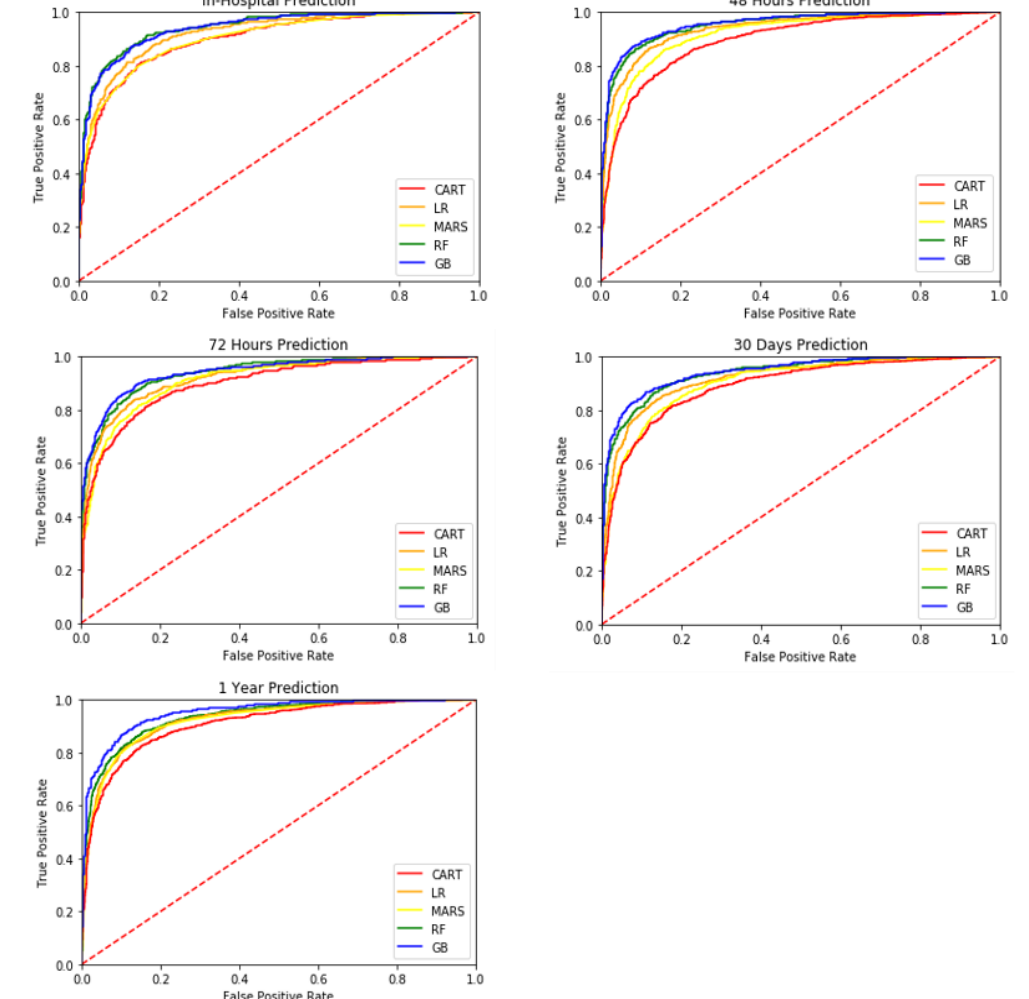
Figure 5. AUROC of different classifiers based on 24 h dataset.